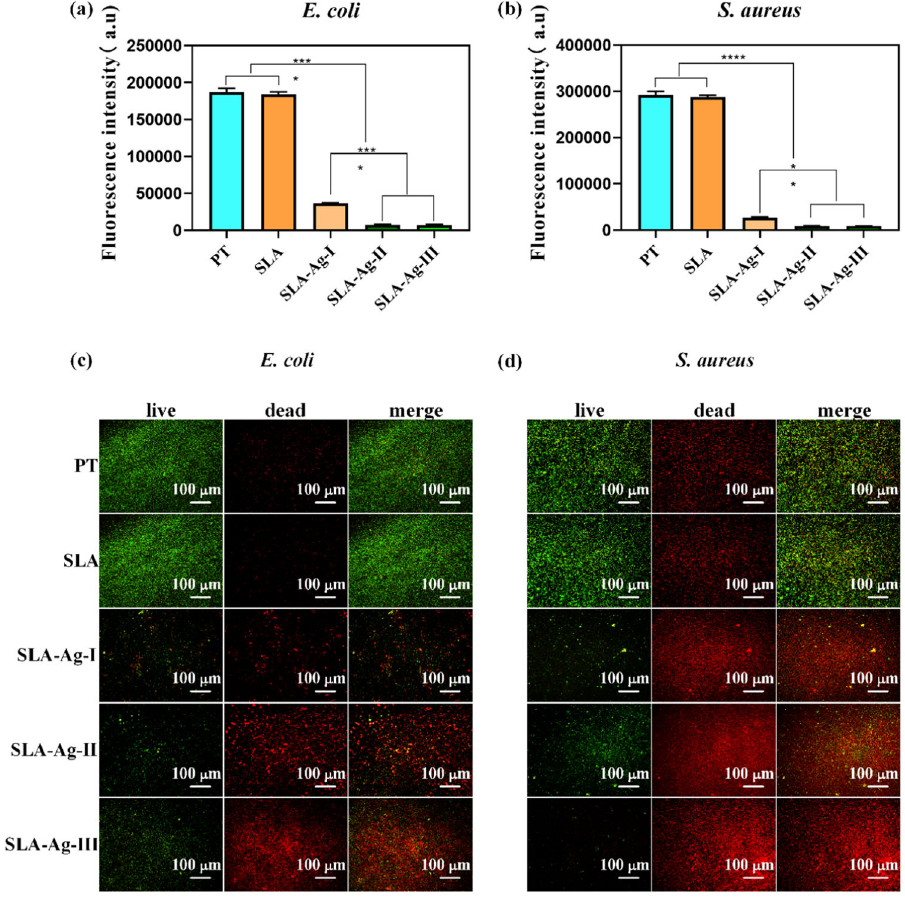
Fig. 4 Viabilities of E. coli ( a ) and S. aureus ( b ) cultured on the samples. Fluorescence images of the live/dead-stained E. coli ( c ) and S. aureus ( d ) cultured on the